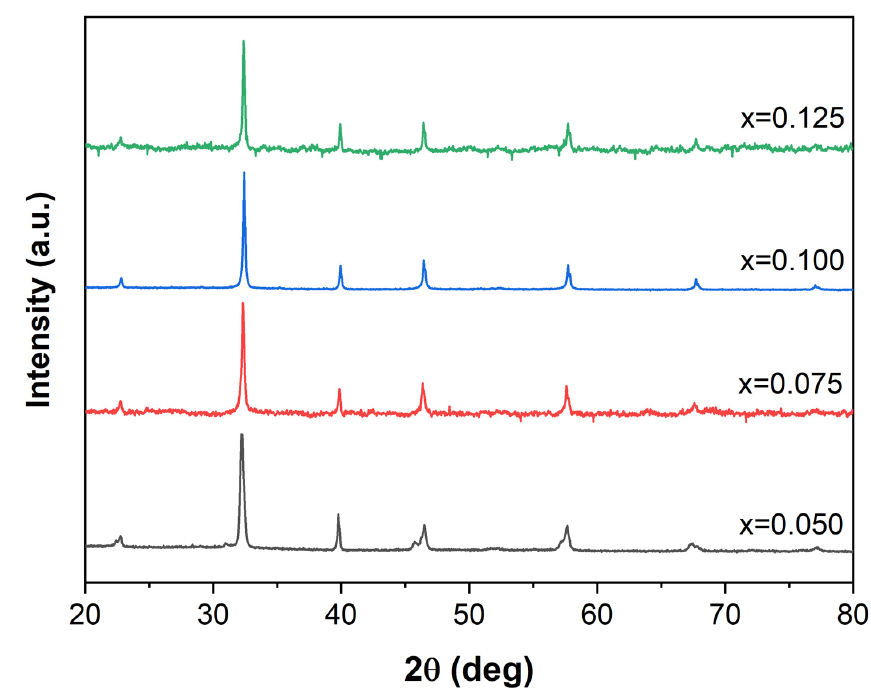
Figure 1. X-ray diffraction patterns at room temperature for (1 − x)(0.8NBT-0.2BT) − xCT compositions with various concentrations.